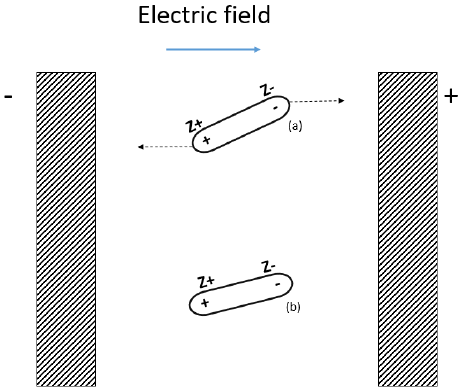
Figure 1. Molecule polarization under the electric field influence ( a ) original state, ( b ) polarized.